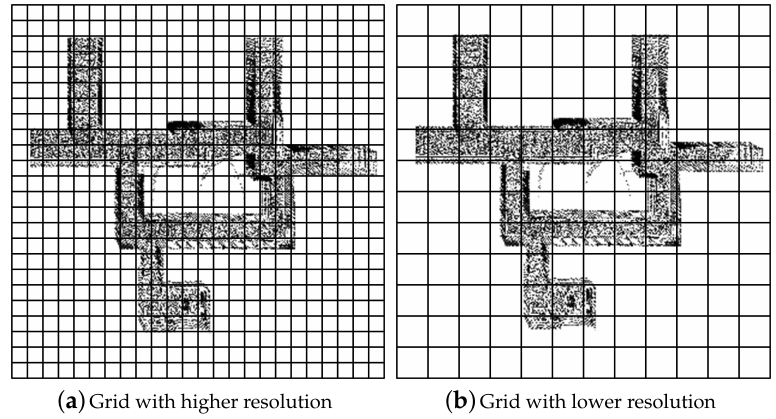
Figure 6. Grid with ( a ) higher resolution, and ( b ) lower